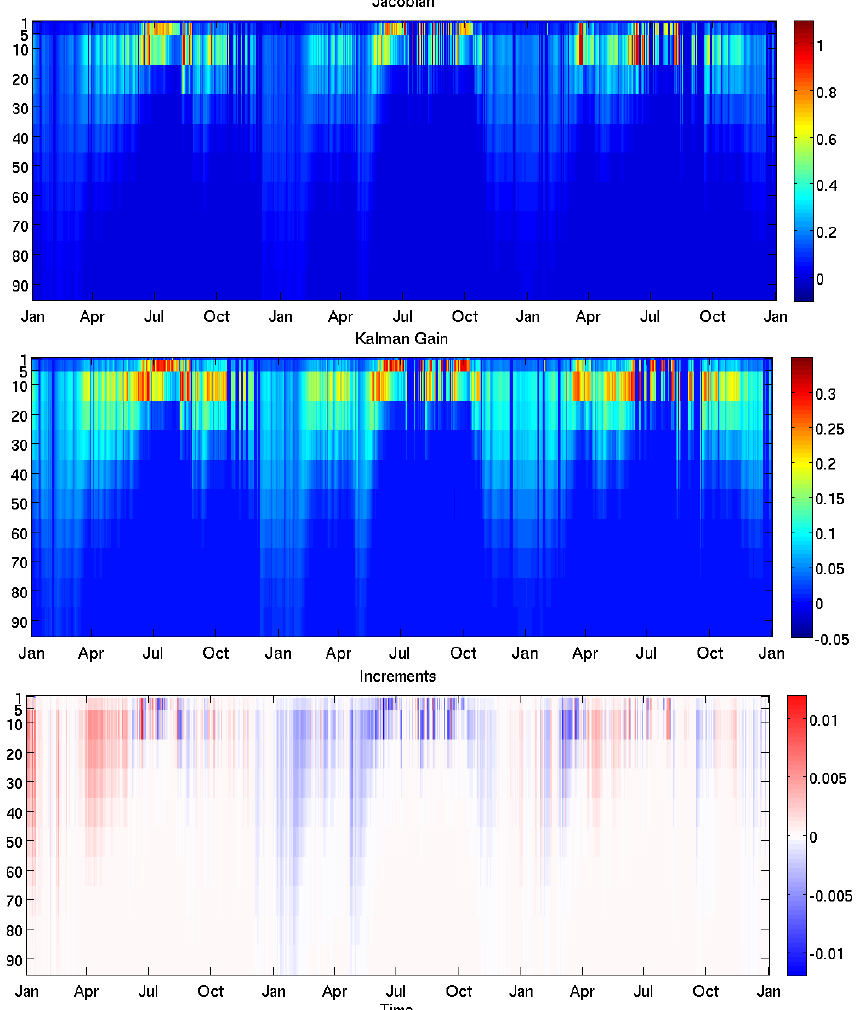
Fig. 9. Representation of the Jacobian (top panel), the Kalman gain (middle panel) and increments (bottom panel) provided by the SSM assimilation for DF-REF. Soil layer depths (in cm) are represented on the left-hand side y axis and time is represented on the x axis.